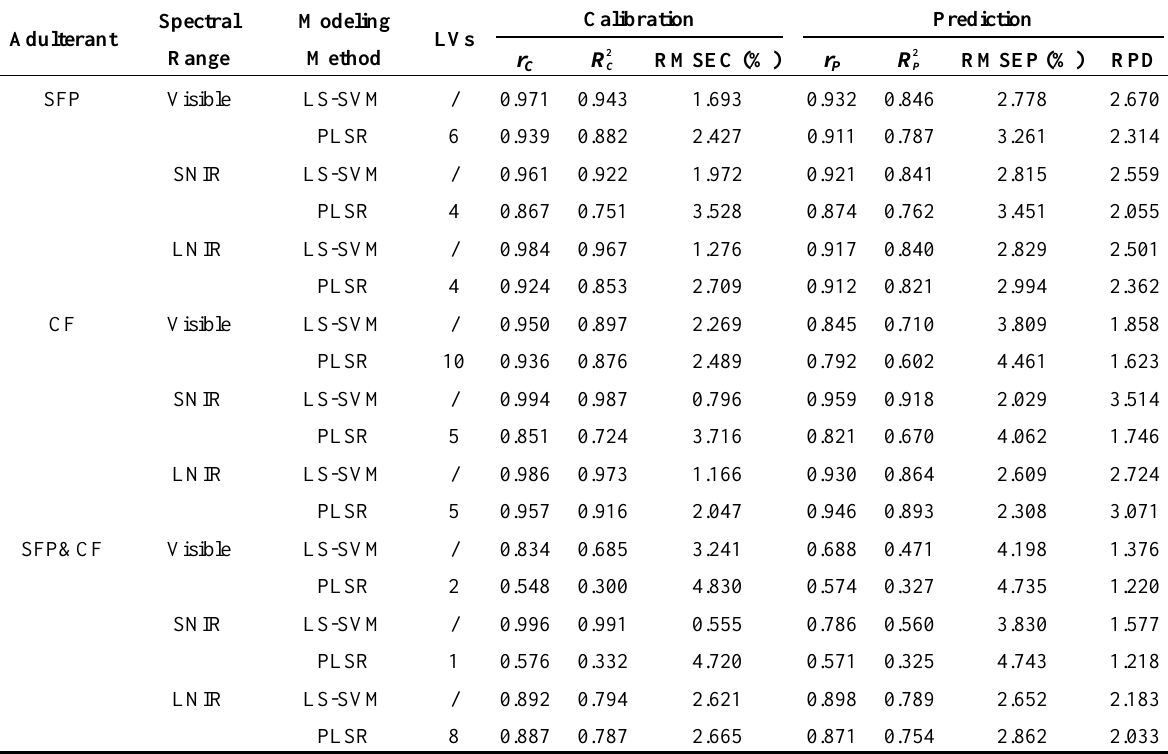
Table 2. Results of regression models for the quantification of Notoginseng powder (NP) adulterated by sophora flavescens powder (SFP), corn flour (CF), and the mixture of two adulterants using least-squares support vector machines (LS-SVM) algorithm based on the data of visible spectra, short-wave near infrared spectra (SNIR), and long-wave near infrared spectra (LNIR),